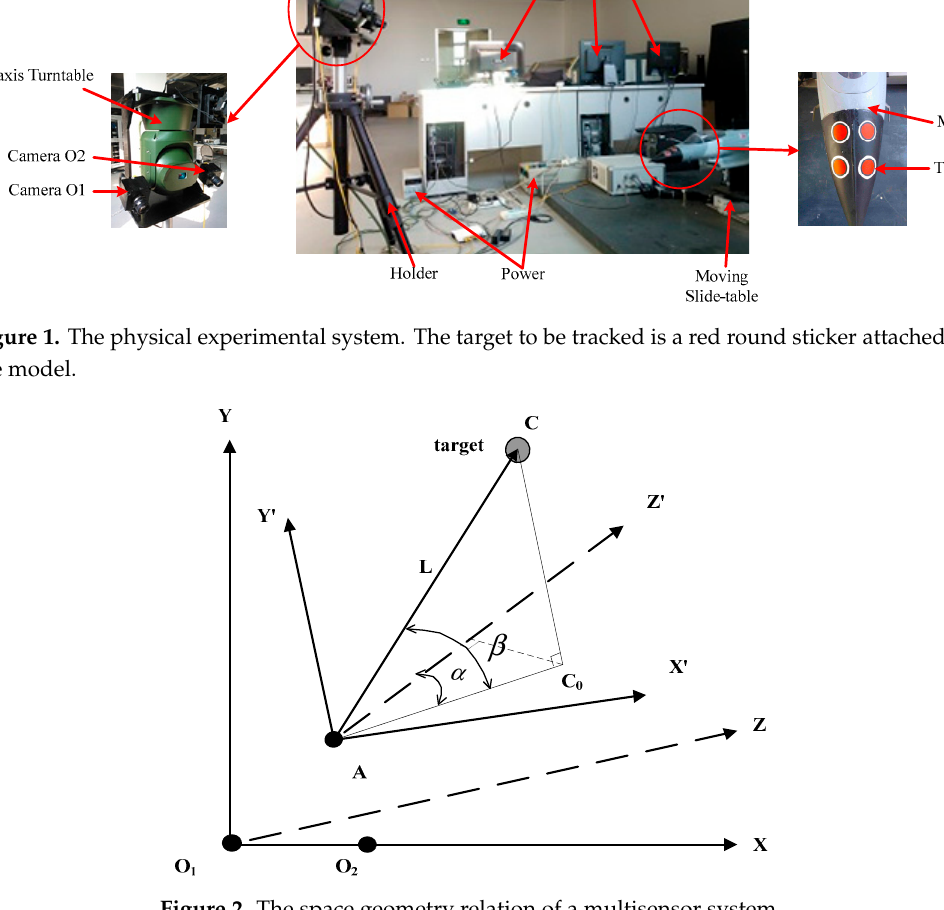
Figure 2. The space geometry relation of a multisensor system.